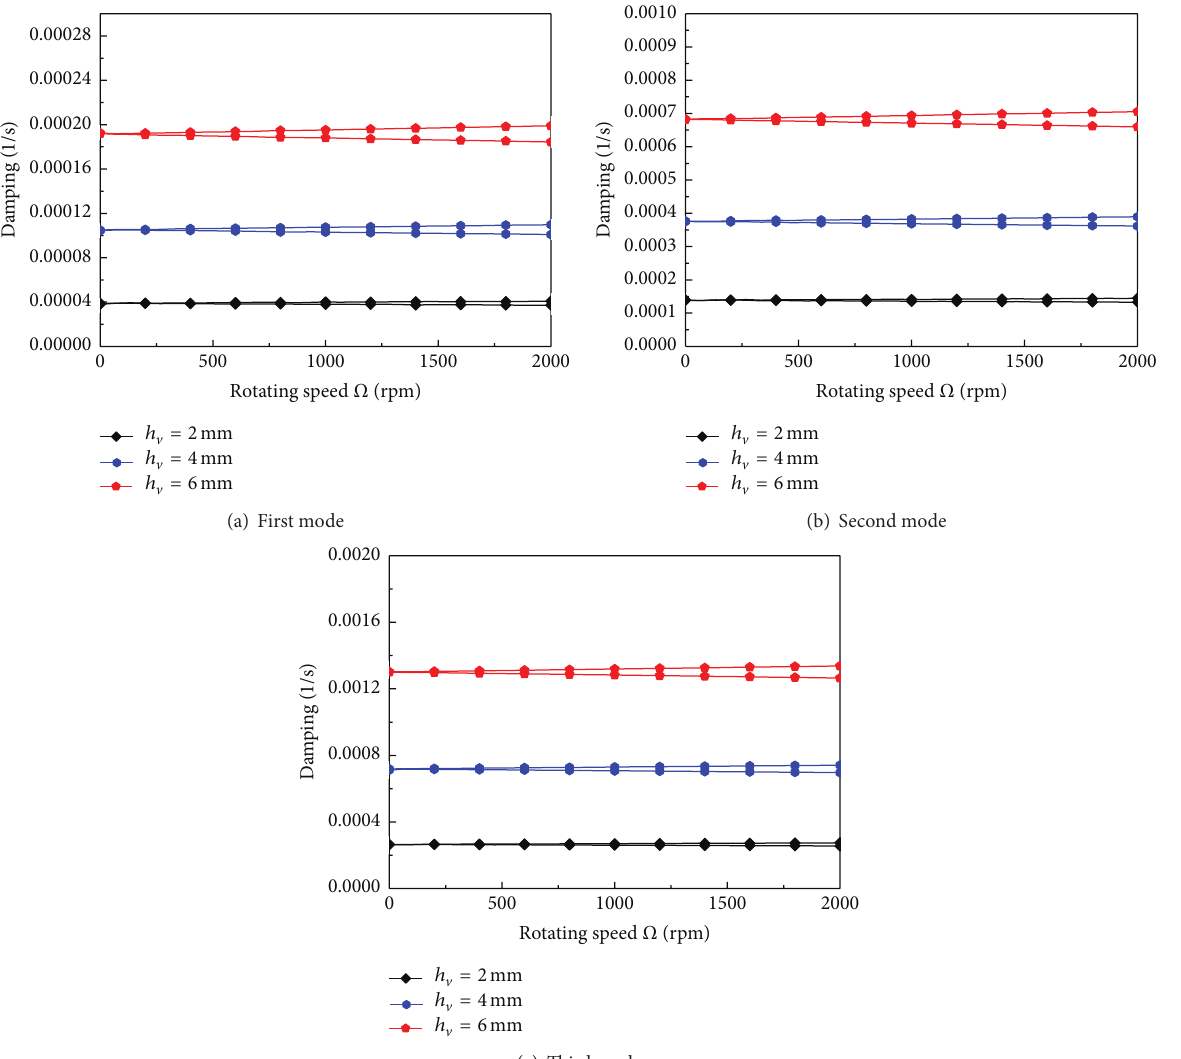
𝐿 𝑟 𝑠 𝑠𝑐 𝐴 𝜂 𝜂 𝑑𝑥, ∫ V V 𝑖 𝑗 ℎ 2 0 V 𝐿 𝜂 󸀠 𝜉 󸀠 𝑑𝑥 − 𝑘 ∫ 12 𝑖 𝑗 0